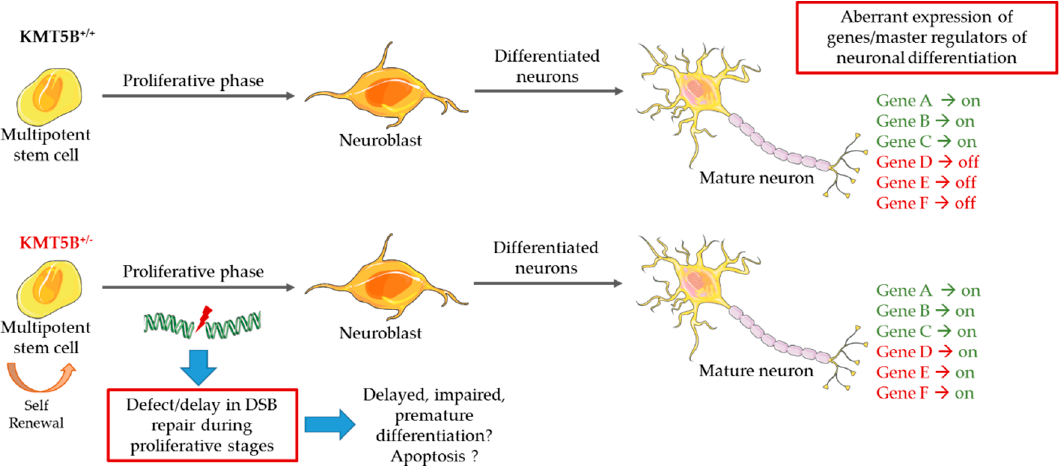
Figure 5. Proposed dual model for KMT5B haploinsufficiency. We propose that KMT5B loss-of-function could result in (1) aberrant gene expression changes and/or (2) defective DSB repair, leading to defects in proliferation and differentiation of neural cells responsible for governing NDD phenotypes.